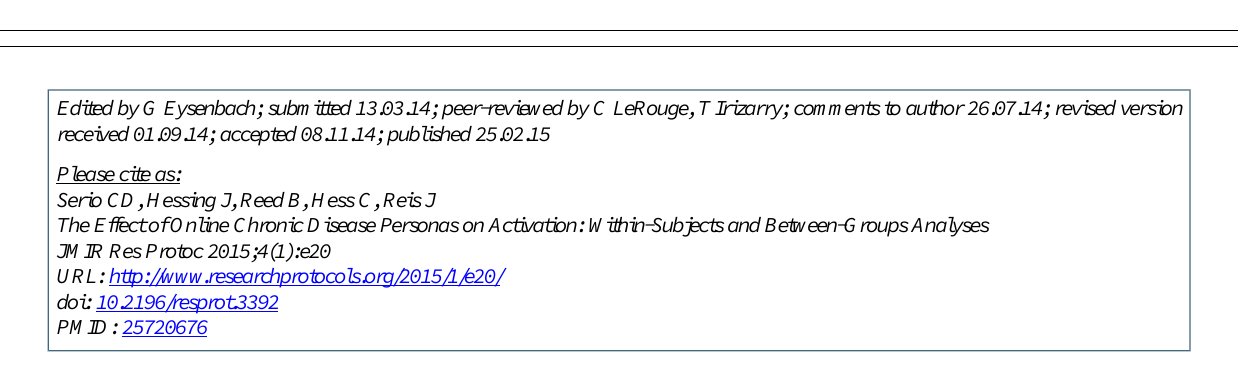
CAD: coronary artery